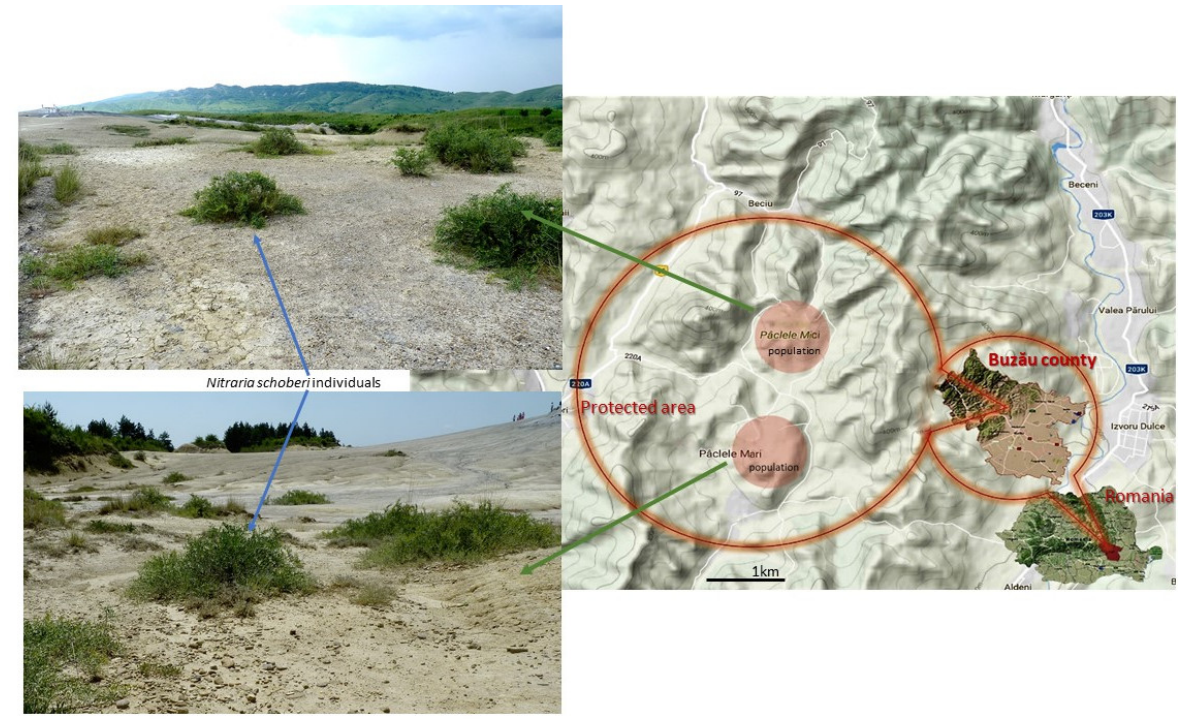
Figure 3. Scheme showing the locations of the assessed populations of N. schoberi, in Romania—green arrows show population views from Pâclele Mici ( up ) and from Pâclele Mari ( down ).